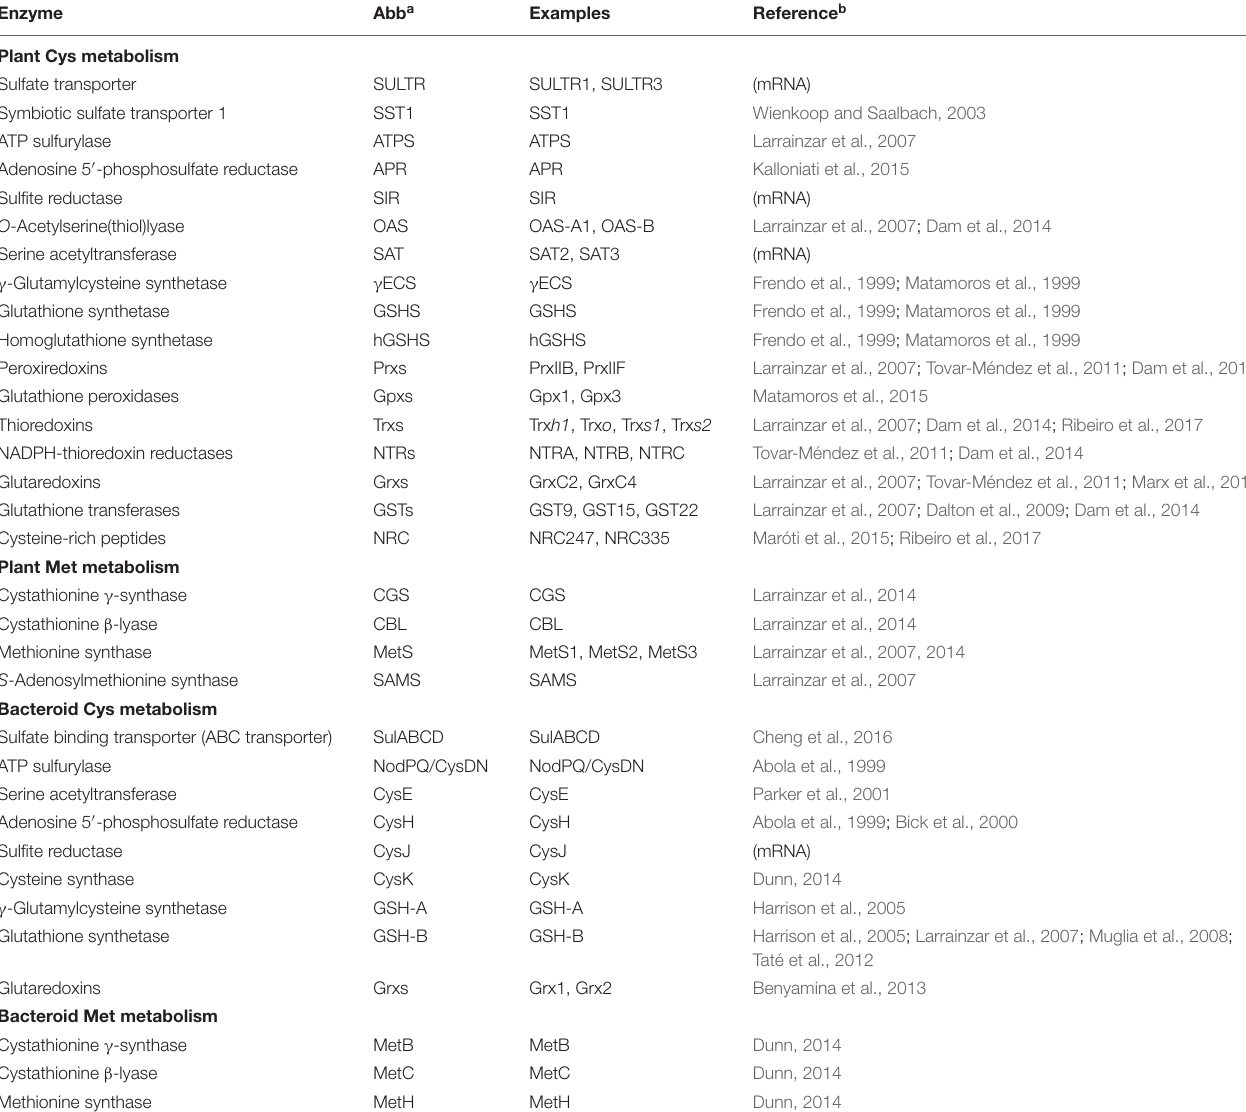
TABLE 1 | Proteins involved in Cys and Met metabolism in the host cells and bacteroids of legume nodules.